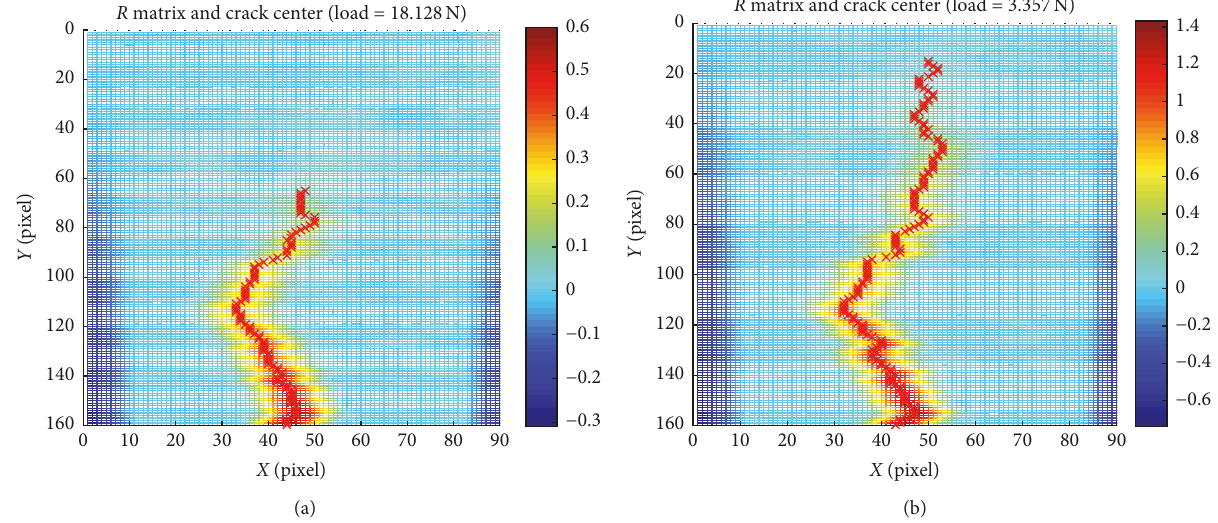
Figure 5: Maps of the cross-correlation function 𝑅 and crack position 𝑃 under (a) Load 1 (18.128N) and (b) Load 2 (3.357 N).